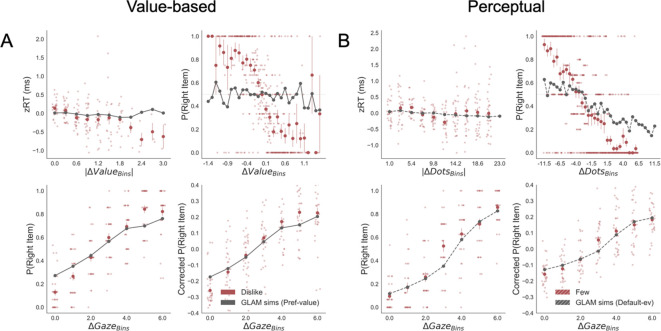
Replication of behavioural effect of interest by simulations using the GLAM fitted for dislike (A) and fewest frames (B).In this case, the models were fitted without adapting the values and dot numbers to the evidence that was relevant for the particular frame, that is the preference value and the default number of dots were used to fit the model in the dislike and fewest frame, respectively. The four panels present four relevant behavioural relationships found in the data. Top left: faster responses (shorter RT) when the choice is easier (i.e. easier choices are found with higher |ΔValue| in value-based and higher |ΔDots| in perceptual). Top right: probability of choosing the right alternative increases when the difference in evidence (value or number of dots) is lower in the alternative at the right side of the screen (ΔValue and ΔDots are calculated consider right minus left options). Bottom left: the probability of choosing the right alternative depends on the gaze difference favouring the right option. Bottom right: the gaze influence on choice depending on the difference in gaze time between both alternatives. No replication of the behavioural effect was found in this case for the relationship between RT -|ΔValue| and RT -|ΔDots| in dislike and fewest frames, respectively. Also P(right item)-ΔValue and P(right item)-ΔDots relationship was not replicated in dislike and fewest frames, respectively. Gaze effect seem to still keep its relationship, since gaze allocation time was not modified to account for the frame shift. Solid red dots depict the mean of the data across participants in dislike and fewest frames. Light red dots present the mean value for each participant. In the Value Experiment, the solid grey lines show the average for model simulations. In the Perceptual Experiment, segmented grey lines show the model simulations. Data are binned for visualisation.